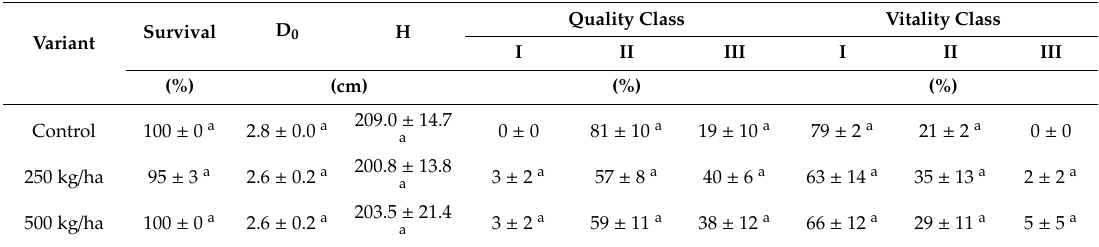
Table 2. Survival, diameter at root collar, height, quality, and vitality of black locust in three years of growth on the combustion waste disposal site.